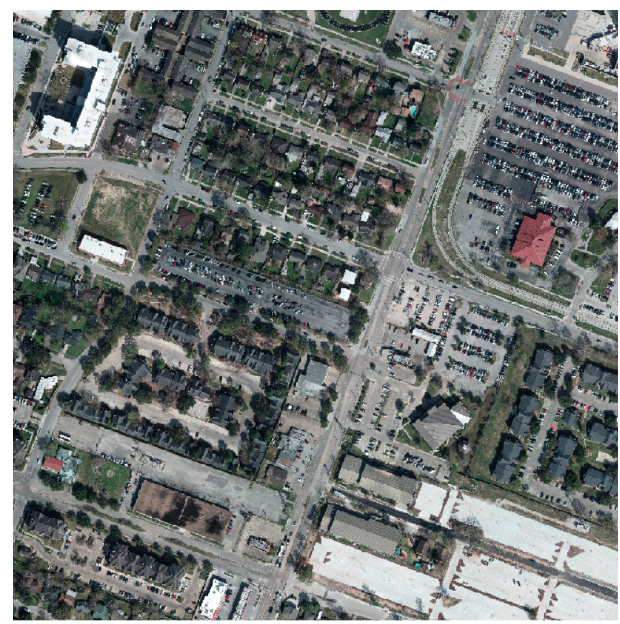
Figure 1. Airborne image of the study area.